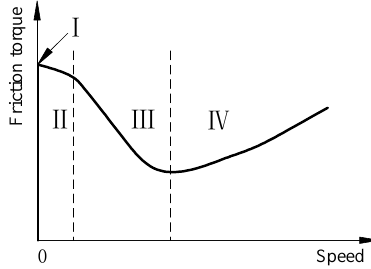
Figure 3. Four friction stages of precision reducers: (I) static friction stage, (II) boundary lubrication stage, (III) partial fluid lubrication stage, and (IV) full fluid lubrication stage.